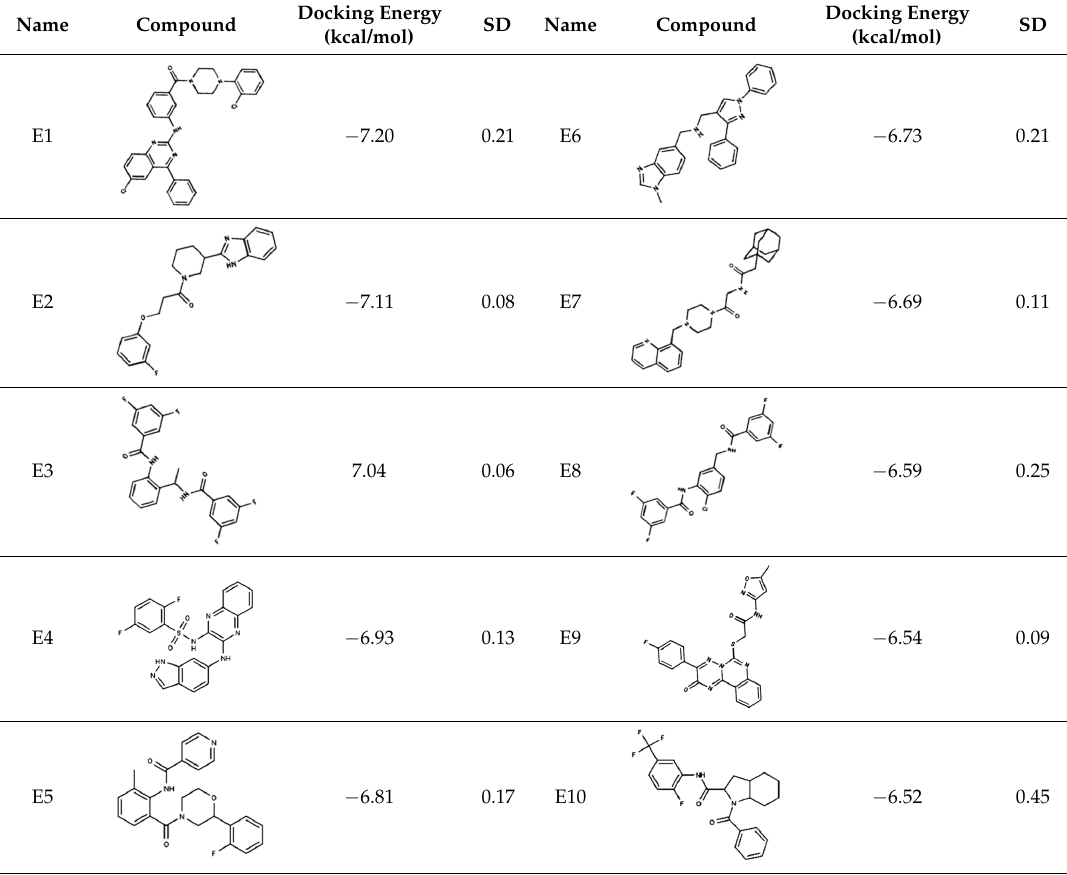
Table 3. Ranking of compounds obtained from DBVS by AutoDock Vina.